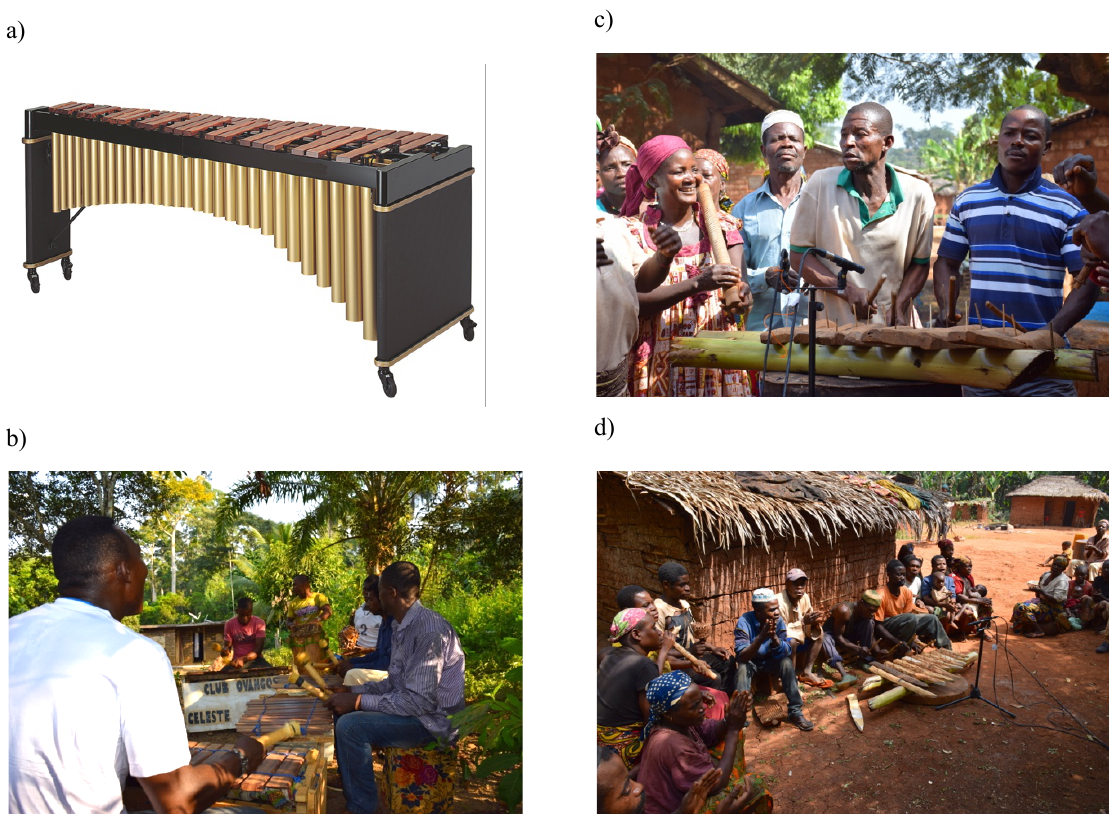
Figure 2. The different types of xylophones studied: a) Western marimba; b) ensemble of xylophones with multiple resonators – Eton, village of Emana, Cameroon; c) banana-trunk xylophone played in a stand-up position - Tikar, village of Beng-Beng, Cameroon; d) banana-trunk xylophone placed on the ground - Bedzan, village of Mansoh, Cameroon. Photo credit: F. Marandola